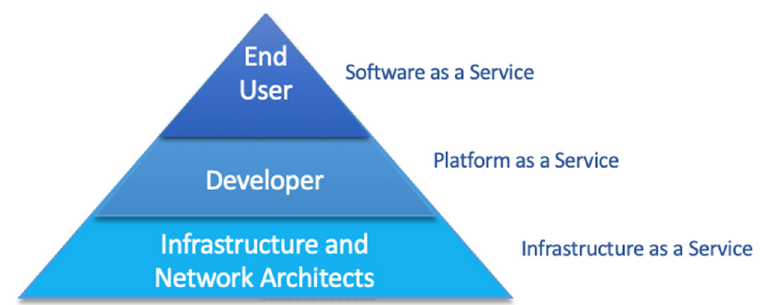
Figure 1. Intelligent Assets Management Platforms (IAMP) software stack pyramid.